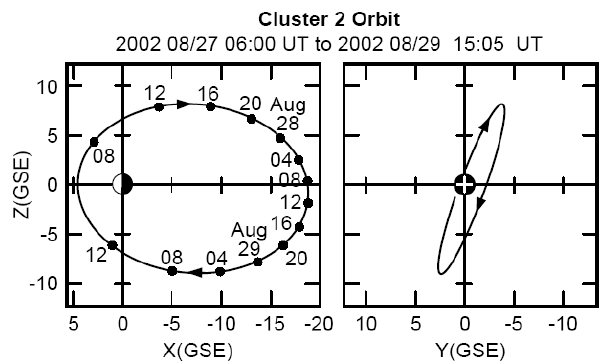
Fig. 1. Cluster orbit in geocentric solar ecliptic (GSE) coordinates (units are Earth radii, R E ) : (left) x-z projection with time labels at four-hour intervals. (right) y-z projection, sunward view (adapted from http://pwg.gsfc.nasa.gov/cgi-bin/gif_walk)